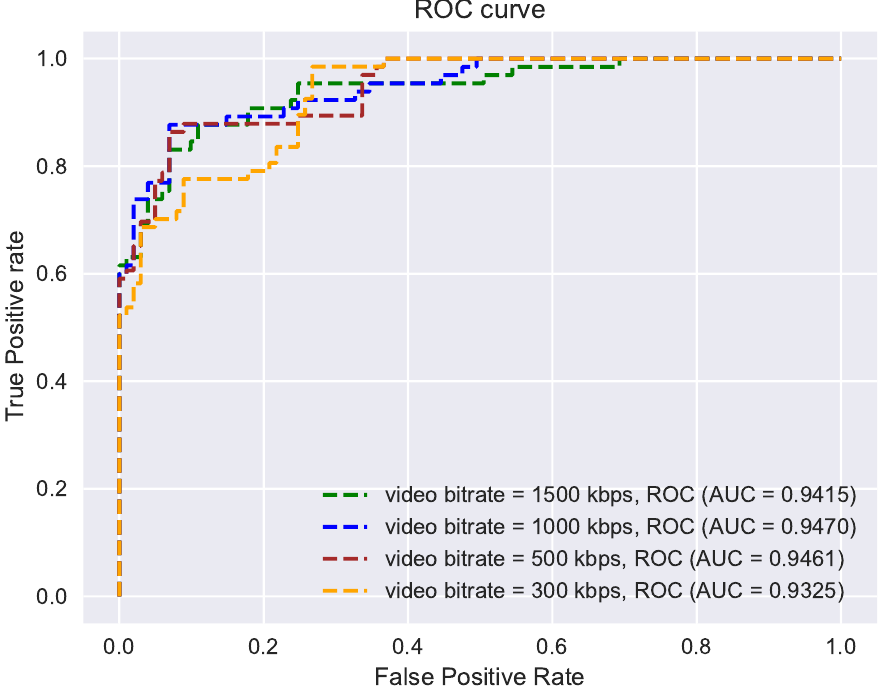
Figure 10. Evaluation of sensitivity of our ensemble multi-stream model to video compression rates: the model produces robust results even at lower bitrates (higher